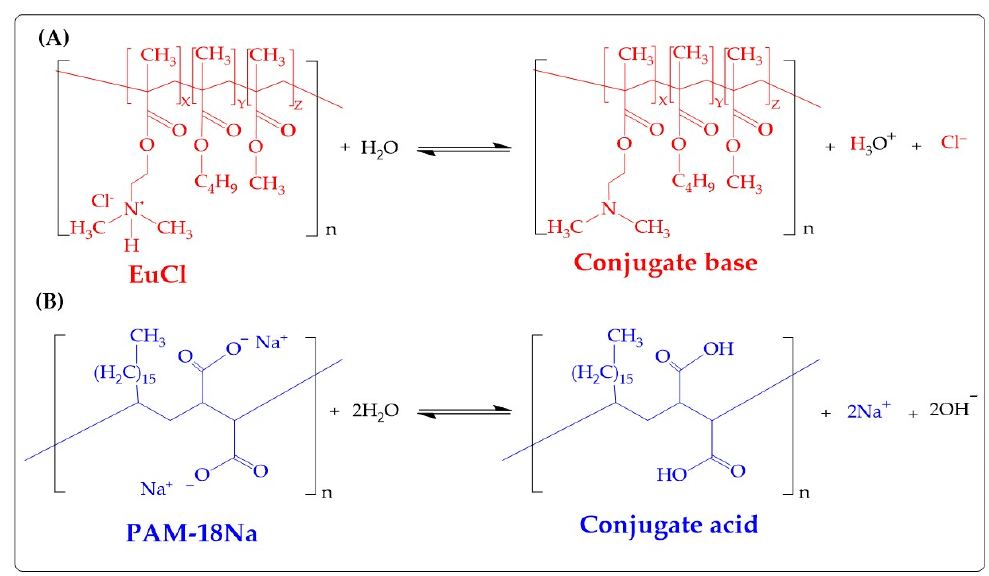
Figure 5. Chemical structure of the ( A ) PAM-18Na and ( B ) EuCl polyelectrolyte monomer units, as well as their ionization process in the aqueous medium. Table 2. Change of the pH of the aqueous medium in the polyelectrolytic complexation process. Molar Ratio Regarding Monomer Case System